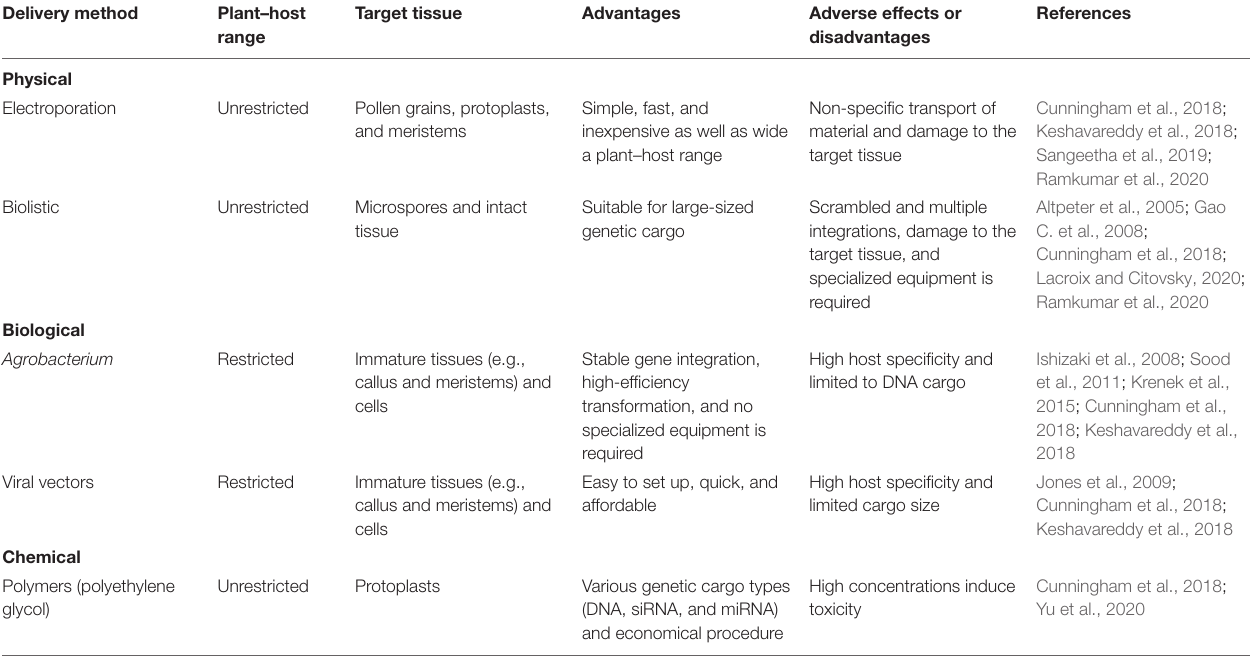
TABLE 1 | Physical, biological, and chemical conventional transformation methods in plants.